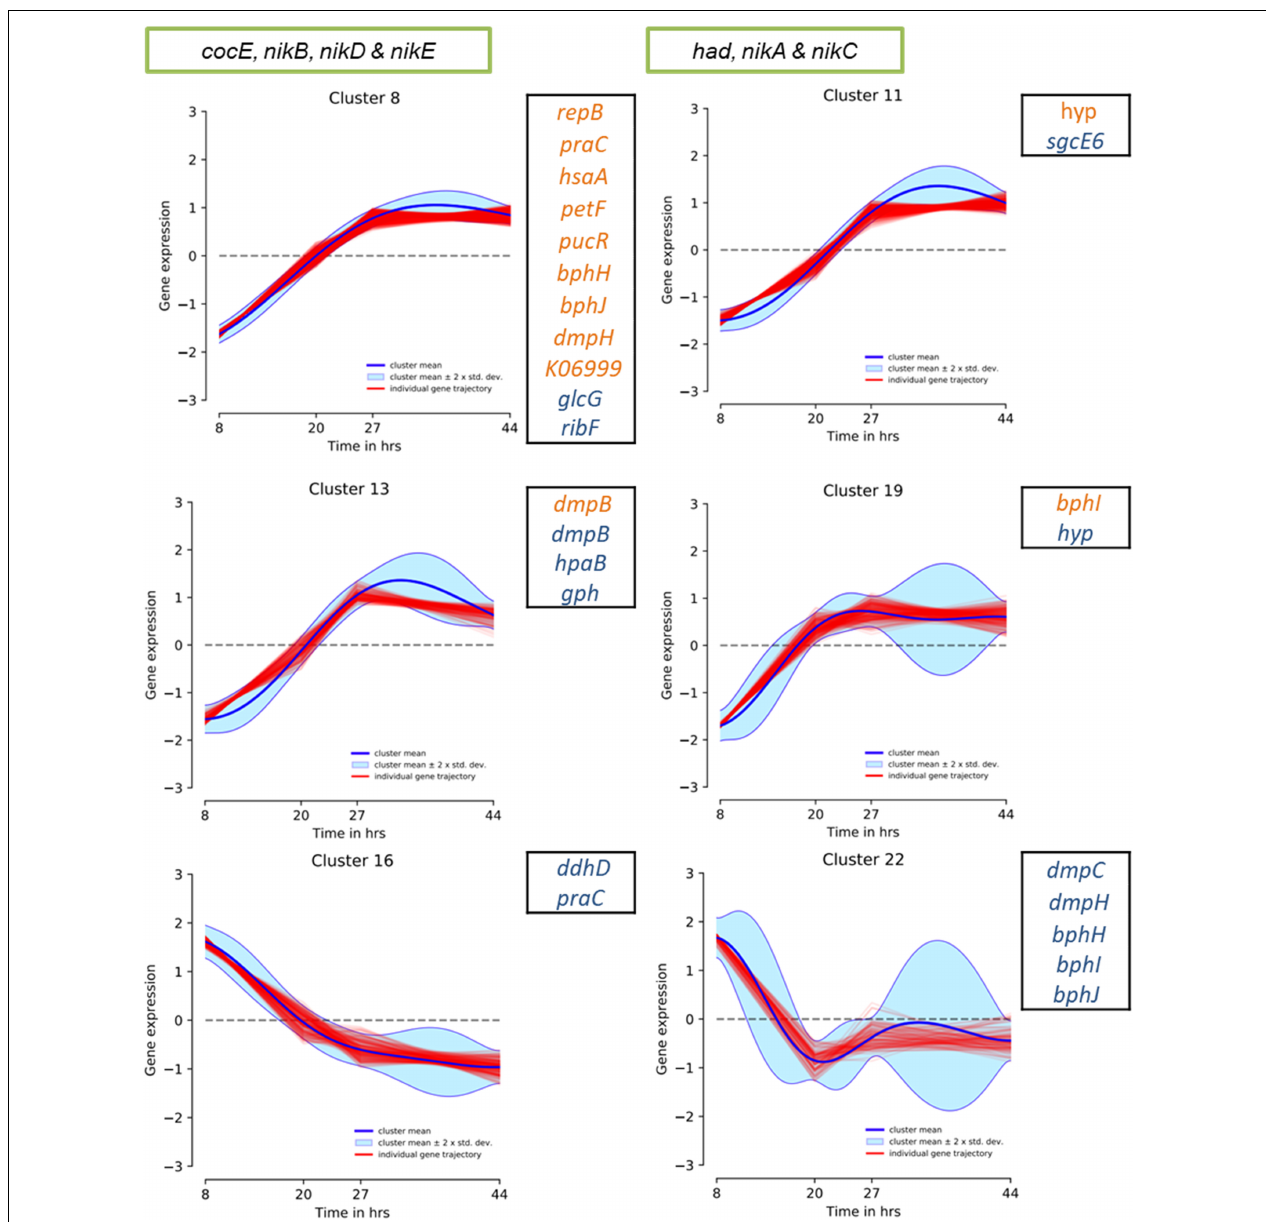
FIGURE 9 | DP_GP_cluster trajectory of P. thermoglucosidasius DSM 6285 differentially expressed genes placed in clusters 8, 11, 13 and 19. The strain was cultivated under an initial gas atmosphere of 50% CO and 50% air and samples were taken for expression analysis using RNA-seq over four time points (Aliyu et al., 2020). Green box indicates genes placed in HSUL 1 and black box highlights plasmids genes of HSUL 2 and PtPL. Blue and orange fonts indicate PtPL and HSUL 2 genes, respectively.